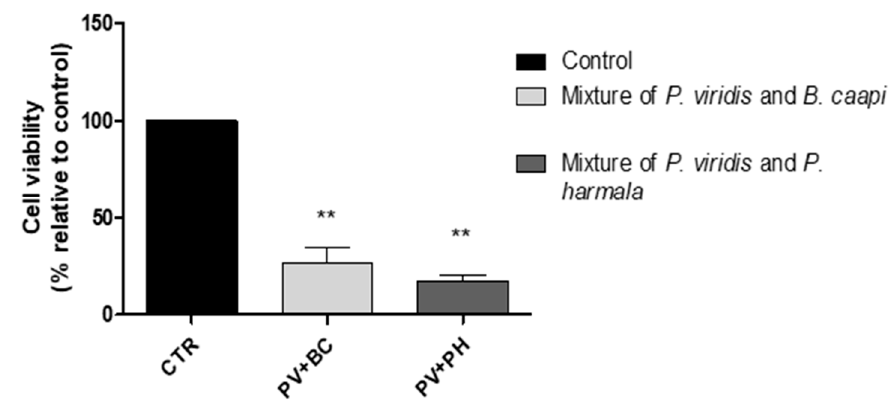
Figure 7. The effects of tea plant extracts mixtures ( P. viridis plus B. caapi and P. viridis plus P. harmala ) on N27 cell viability ( n = 3). The presented values are presented as mean ± SEM. ** indicates values that are significantly different from control ( p < 0.05, one-way analysis of variance (ANOVA)). CTR— control.